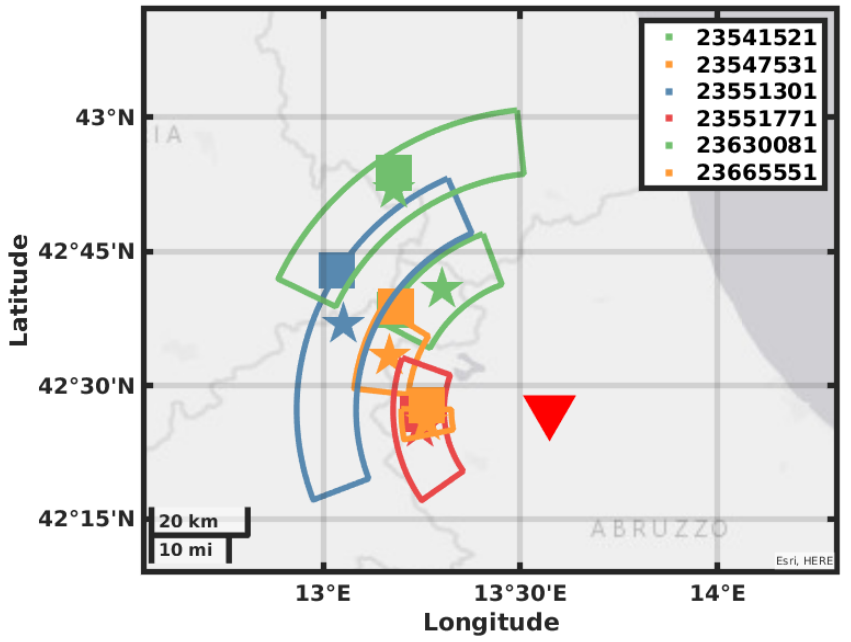
Figure 10. Map showing the GIGS station location, the earthquakes located by the INGV in solid squares, the earthquakes located using the GIGS station and the relative location error in polar